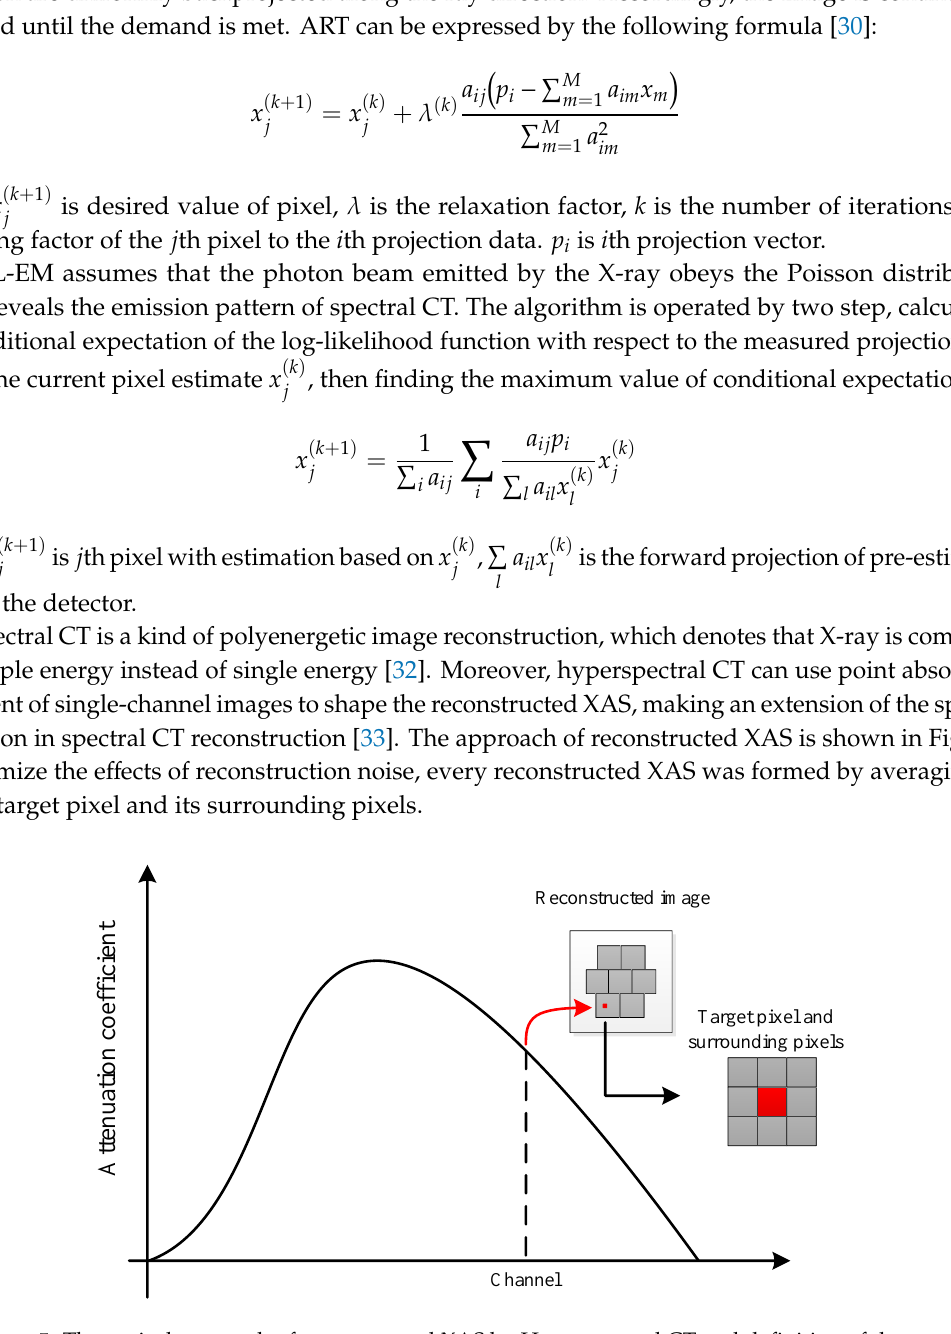
Figure 5. Theoretical approach of reconstructed XAS by Hyperspectral CT and definition of the target pixel and its surrounding pixels